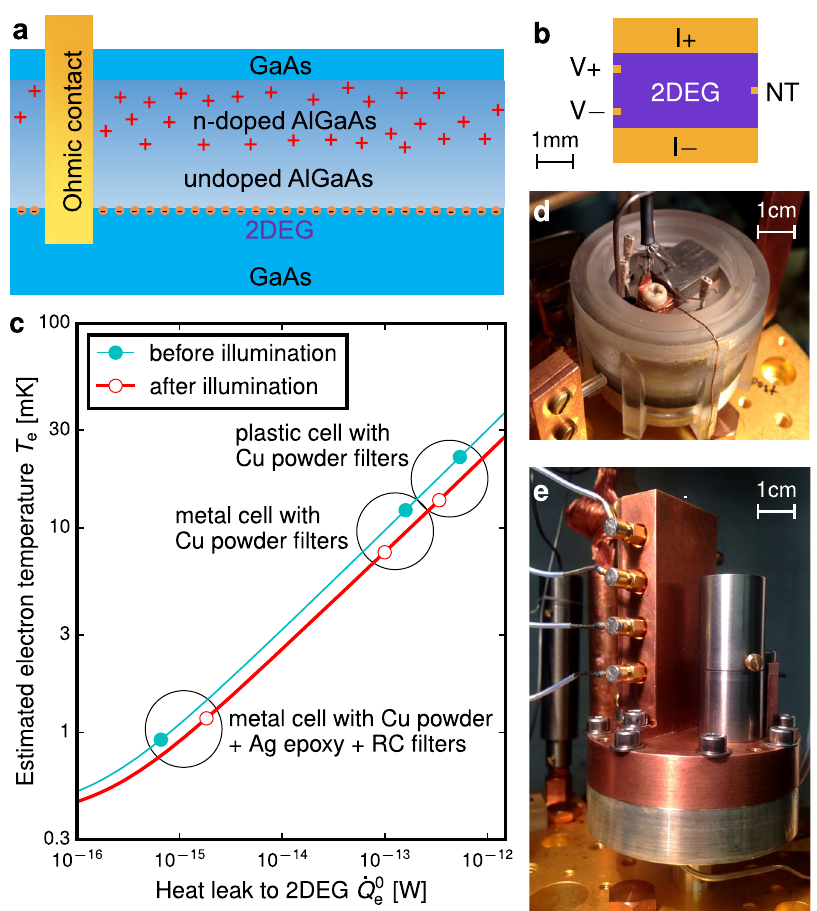
Fig. 1 Cooling electrons in a 2DEG in 3 He immersion cells. a Schematic of the sample: the 2DEG is created at a GaAs/AlGaAs heterojunction, and electrical connections are provided by AuNiGe ohmic contacts. b Top view of the 4 mm × 4 mm device cooled to 1 mK by the I± and V± ohmic contacts, also used to measure the electrical resistances in the device. A noise thermometer (NT) is connected to the NT ohmic contact to probe the electron temperature T e . c Progressive cooling of the 2DEG device in plastic ( d ) and metal ( e ) immersion cells equipped with different low-pass fi lters. T e is estimated from Eq. (4), assuming that the 3 He bath is at temperature T bath = 0.3